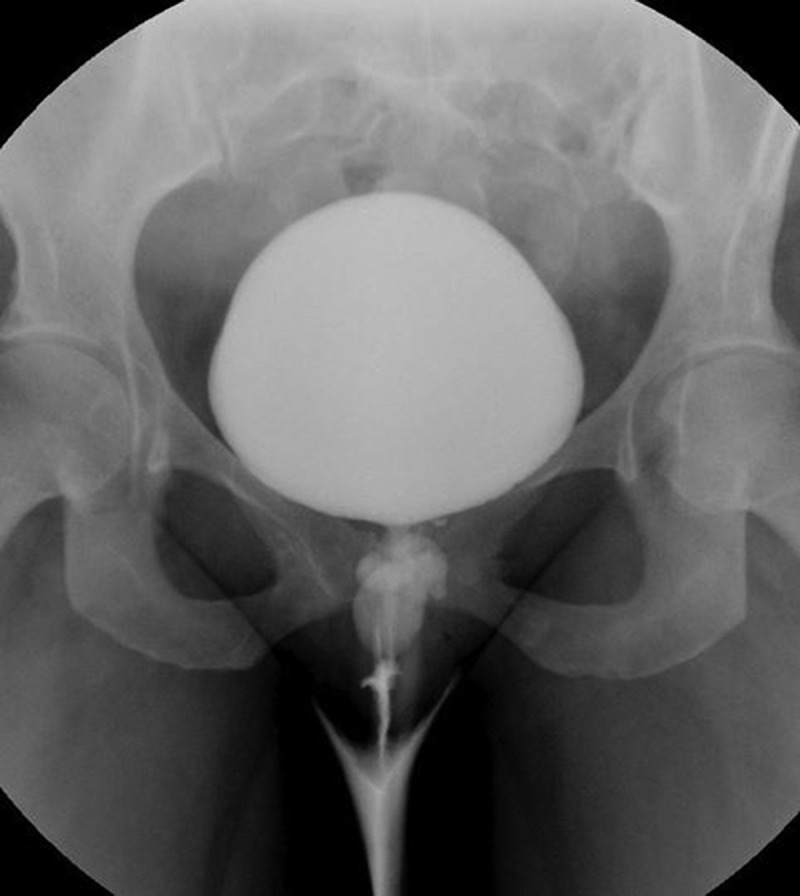
VCUG notable for a lobulated opacification inferior to the bladder, consistent with a large, multi-lobulated UD.